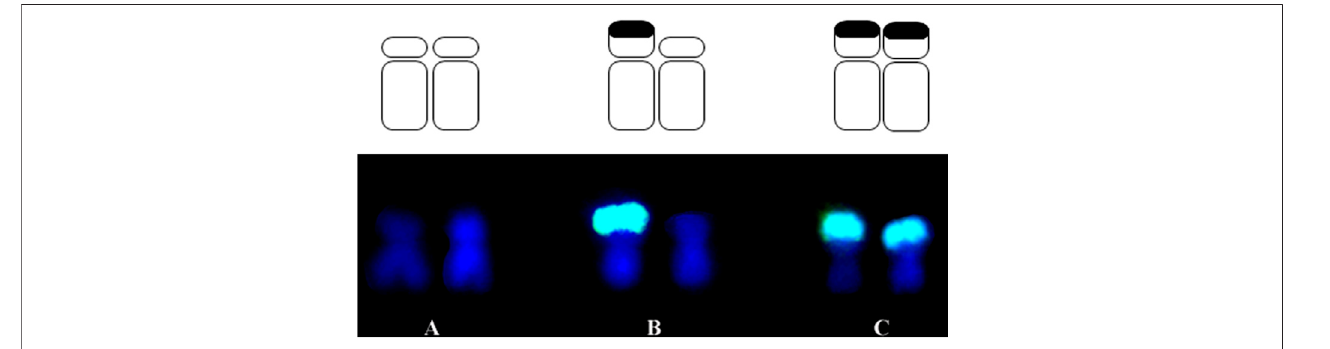
FIGURE 1 | Representation of the knob conditions for chromosome 9 (K9S). (A) Absence of knob (B) heterozygous knob and (C) homozygous